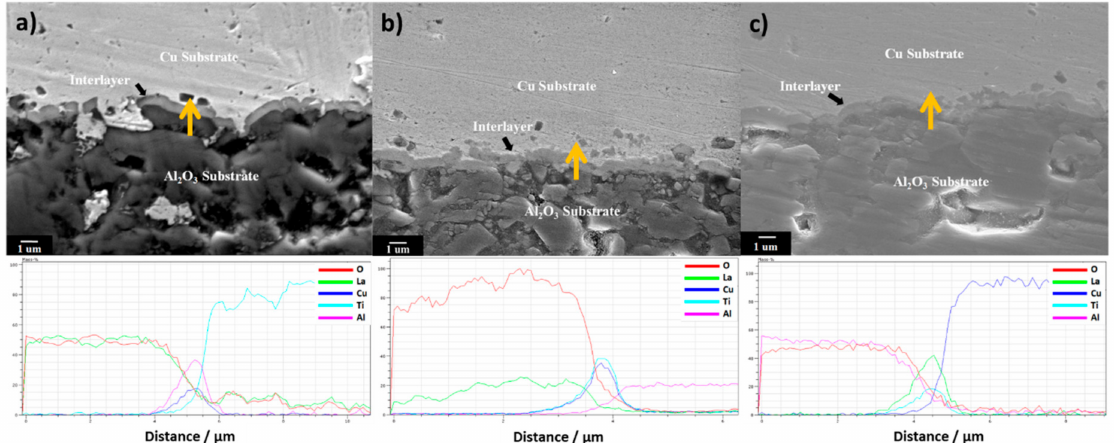
Figure 3. Cross-section images showing heterogeneous bonding of the alumina substrate and copper substrate, and line scans for various process temperatures: ( a ) 250, ( b ) 300, and ( c ) 350 ◦